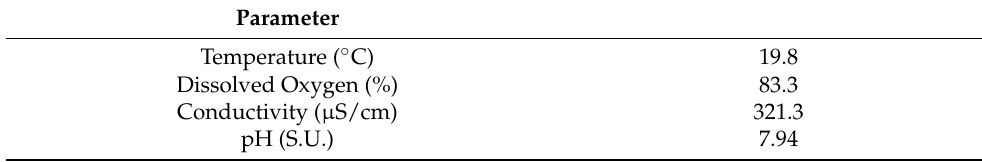
Table 1. Water characteristics measured in situ before experimental algaecide